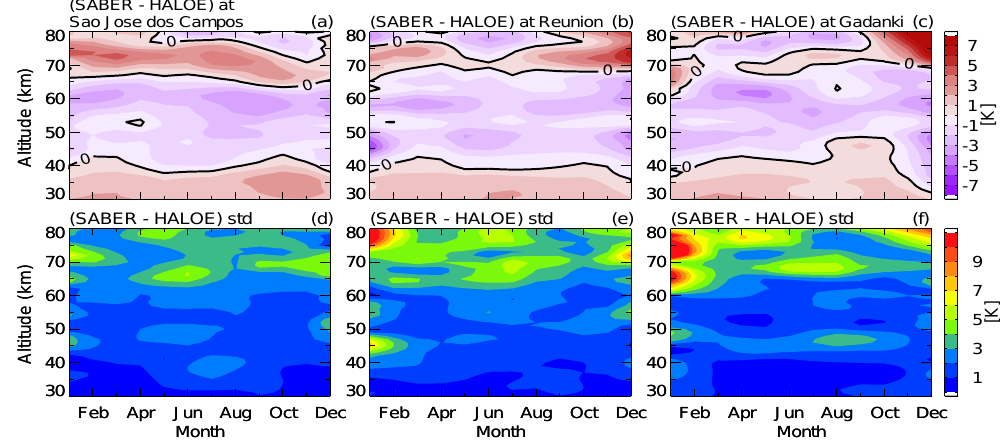
Fig. 3. Monthly mean temperature differences observed between SABER and HALOE over São José dos Campos, Gadanki and Reunion locations. Respective standard deviations are shown in the lower